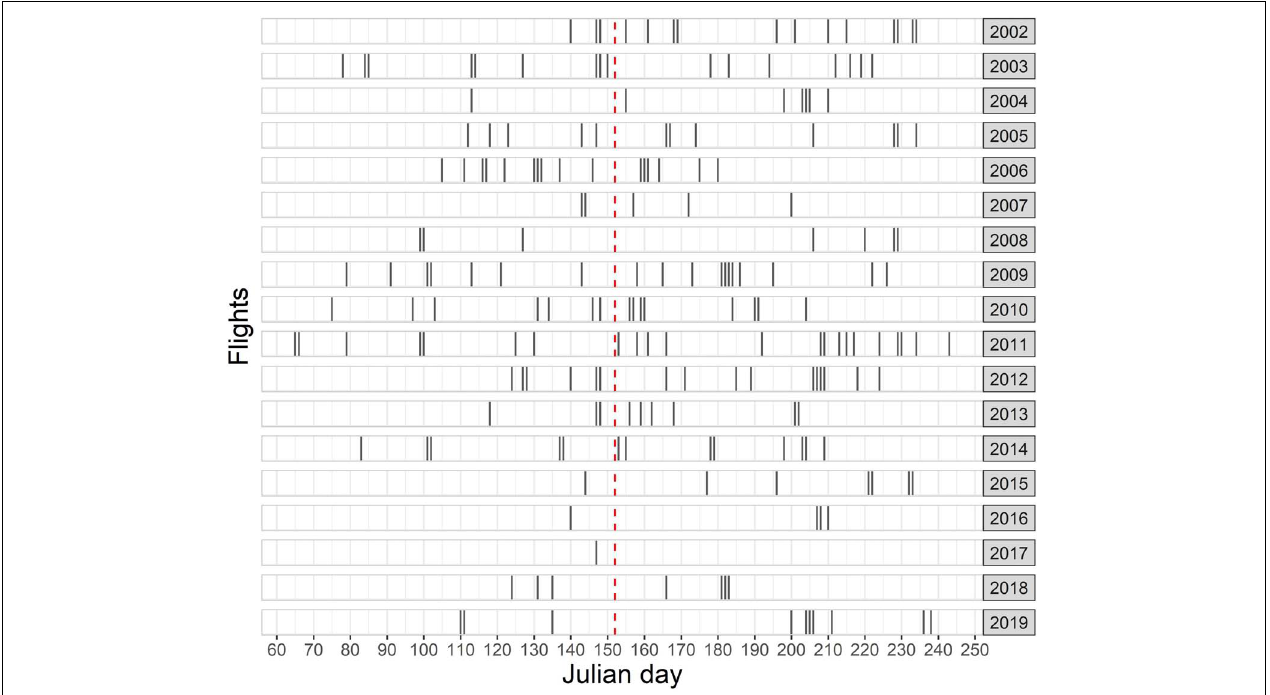
FIGURE 3 | Total number of aerial survey flights conducted in the frame of the national visual monitoring and related research projects between 2002 and 2019 in the German North Sea. Timing of each flight is shown with respect to the Julian day. The red dashed line shows the transition from spring to